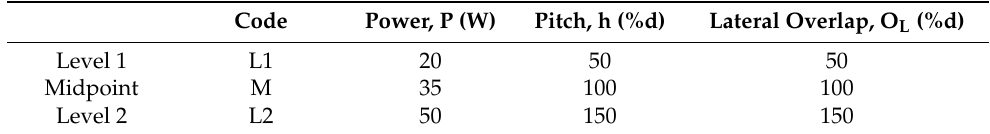
Figure 3. A three-factor layout for face-centered central composite design (FCCD). Table 2. Process parameters adopted and levels for laser